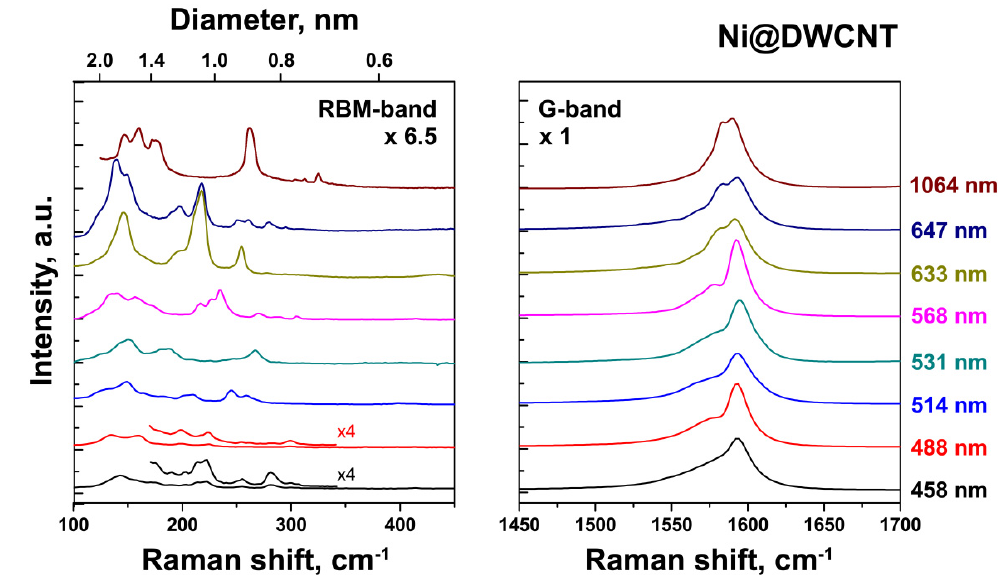
Figure 3. The RBM- and G-bands of the multifrequency Raman spectra of SWCNTs filled with nickelocene heated at 900 °C for 2 h.